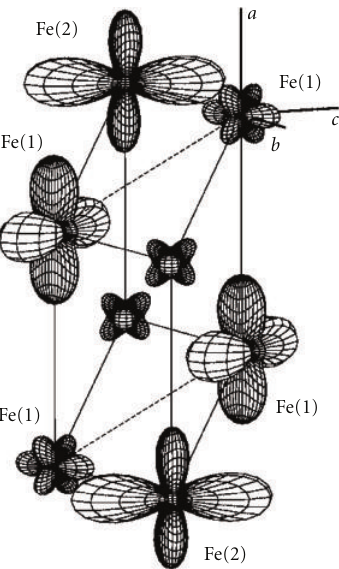
Figure 18: The angular distribution of the majority and minority spin 3 d electron density of the Fe(2) and Fe(1) cations, respectively, from di ff erent Fe ribbons [211]. The size of orbital corresponds to its occupancy. The frame of four Fe(1) atoms from the Fe ribbon presented in Figure 17 is shown by dashed lines.